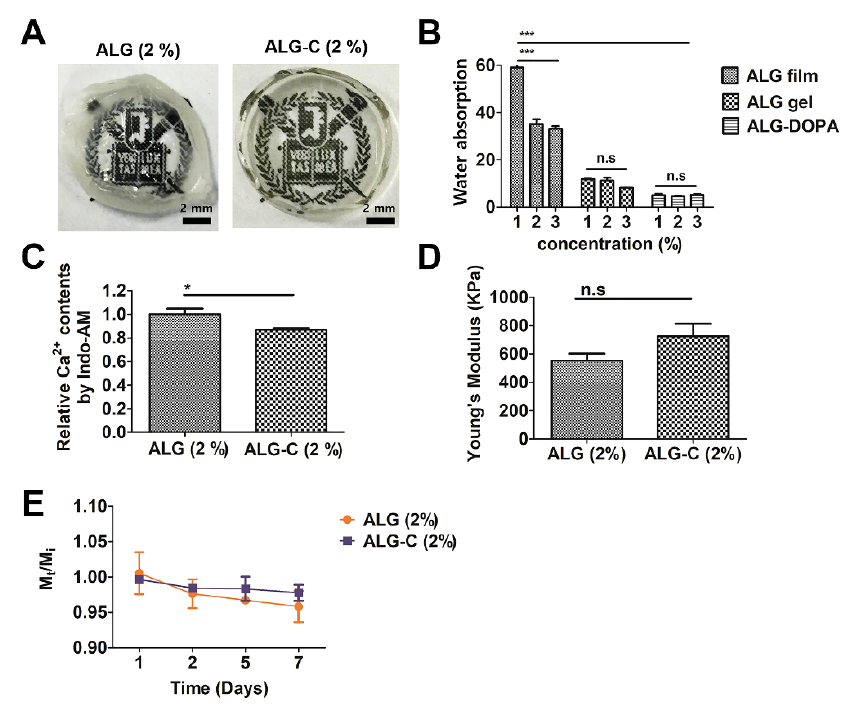
Figure 4. Optical property and water absorption of both ALG and ALG-C films. ( A ) Photographic image of the 3D-structured films. The ALG-C has higher optical transparency than ALG. ( B ) The water absorption of conventional ALG hydrogel, ALG films, and ALG-C films. ( C ) Relative Ca 2+ ion concentration within the films was measured by Indo-AM assay. ( D ) Quantification of Young’s modulus of ALG and ALG-C films. ( E ) Degradation kinetics of ALG and ALG-C films. All the experiments were conducted in triplicate (* p < 0.05, *** p <